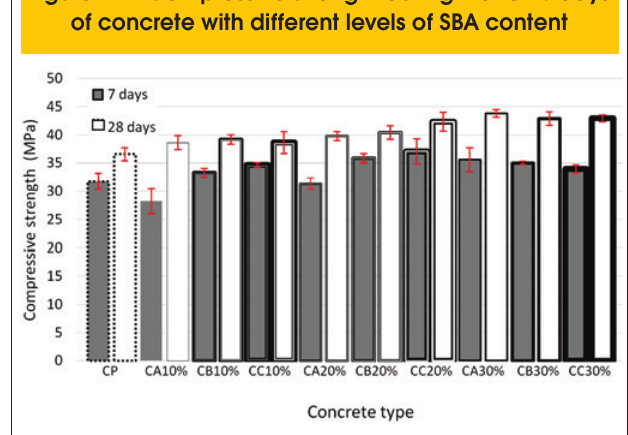
Figure 12 – Compressive strength during 7 and 28 days of concrete with different levels of SBA content